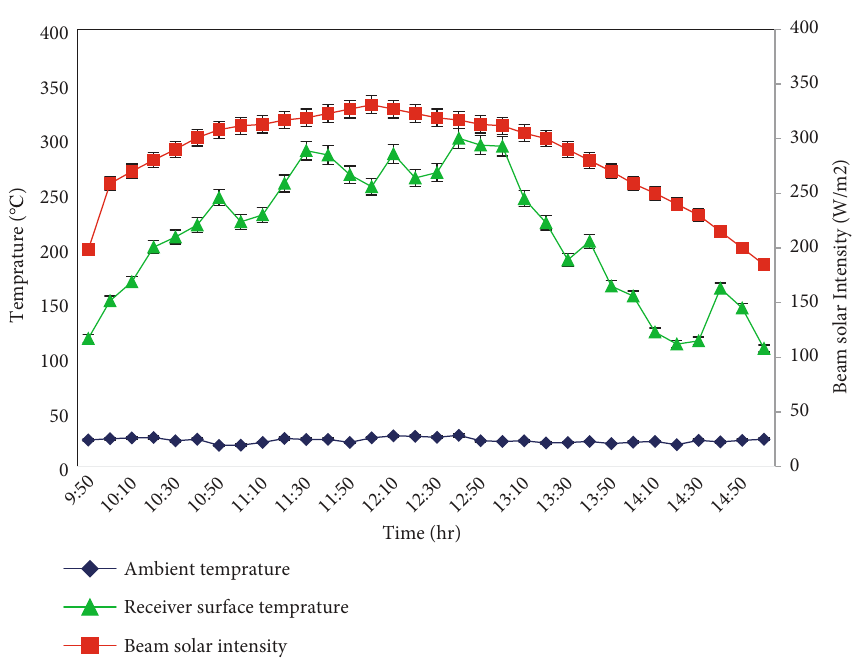
Figure 5: Temperature distribution over the receiver surface, ambient temperature, and solar radiation